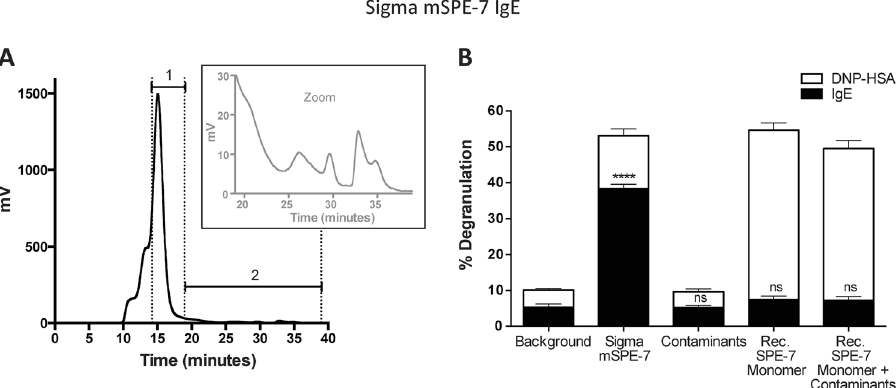
Figure 2. Small protein contaminants in the Sigma mSPE-7 IgE preparation are not responsible for its cytokinergic activity. ( A ) Analysis of the unpurified Sigma mSPE-7 IgE preparation by size-exclusion chromatography using the Superdex S200 HPLC column revealed the presence of small protein contaminants. Fractions smaller than monomeric IgE (fractions 1) were collected and pooled as small contaminants (fractions 2, also magnified in inset). ( B ) Although unpurified Sigma mSPE-7 IgE, in the absence of antigen, resulted in significant RBL-SX38 degranulation compared to buffer background control (black lower bar; **** P < 0.0001), the contaminants alone or in combination with 5 μ g/ml recombinant SPE-7 IgE monomer, did not exhibit any cytokinergic activity (black lower bars; ns P > 0.05). Means of 3 independent experiments ± SEM are shown. Statistically significant difference to background control was determined by one-way ANOVA with Dunnett’s post-test.